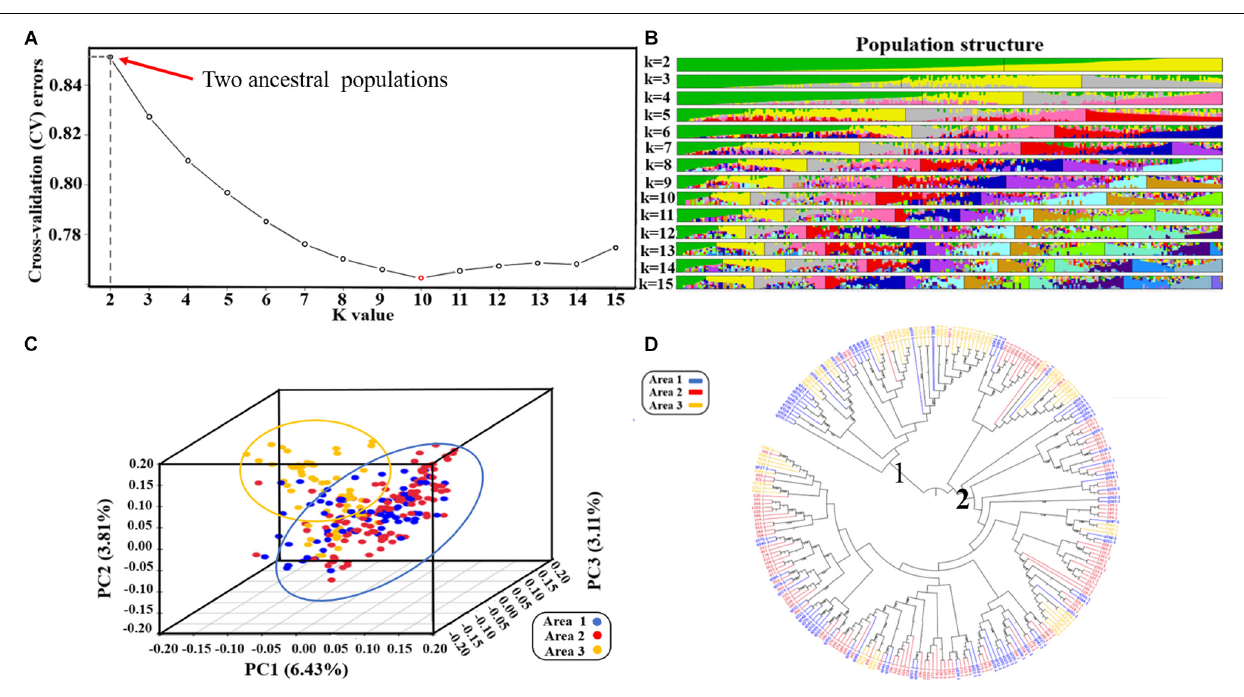
FIGURE 2 | Population structure of 260 genotypes of spring soybean (Liu et al., 2020): (A) Diagram showing the value of 260 samples based on clustering from 1 to 15; Cross validation error rate for each K -value of 1–15, X -axis is K -value 1–15, Y -axis is cross-validation errors. (B) Clustering analysis when the number of subgroups is in the range 2–15, the colors represent separate groups. (C) Three-dimensional score plot (PCI, PC2, and PC3) to discriminate between soybeans lines from three provinces of China. (D) Phylogenetic tree of 260 soybean lines. Areal represents the soybean lines from Jilin province, Area2 represents the soybean lines from Heilongjiang province, Area3 represents the soybean lines from Liaoning